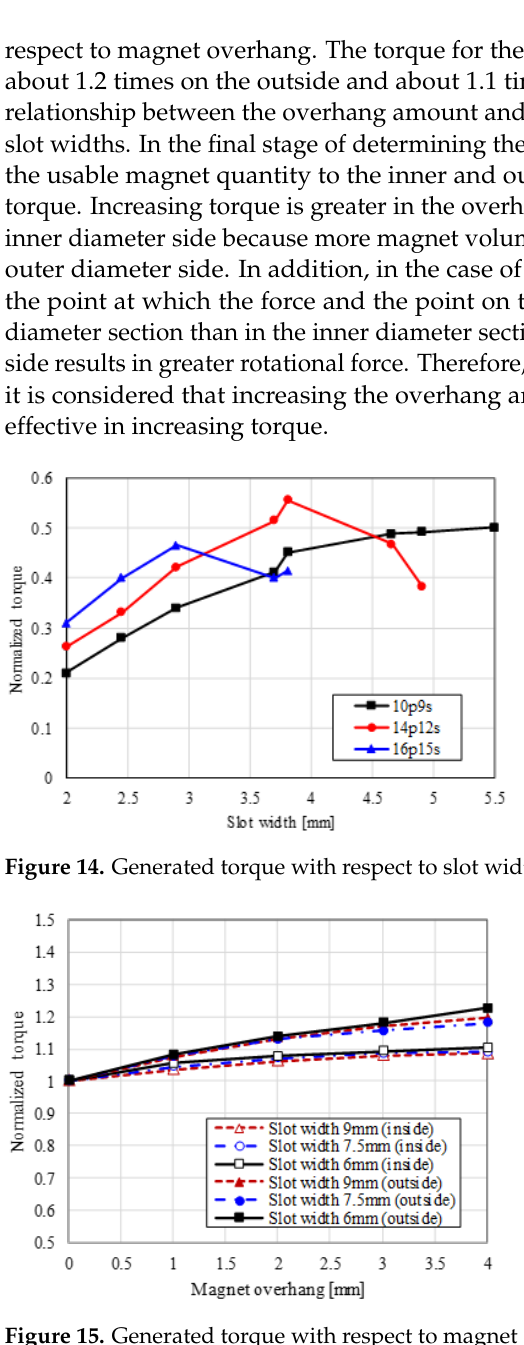
Figure 16. Average torque in each model. 3.4. Results of Verification of Equipment Figure 17 shows the structure of a prototype axial-gap motor, and Figure 18 shows a prototype axial-gap motor. Table 5 shows the specifications of the axial-gap motor. The motor diameter is 80 mm, stack length is 34.8 mm, and the prototype motor has an SPM type rotor with 14 poles, and a 12 slot stator with a three-phase concentrated winding. Since the magnetic circuit in the stator core is three-dimensional, Soft Magnetic Composite